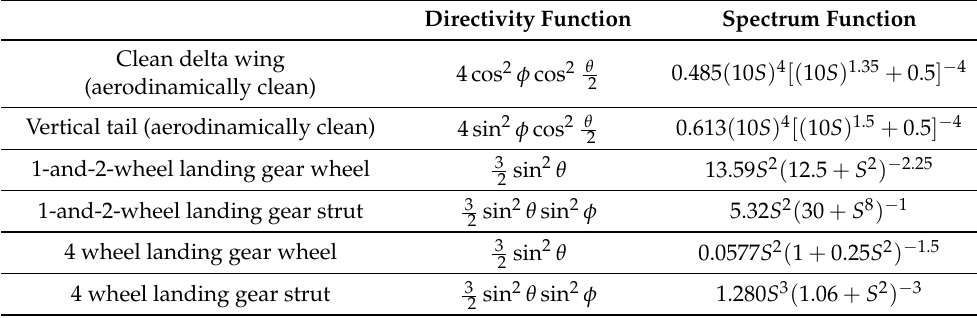
Table 3. Directivity function D and Spectrum function F ( S ) for each airframe noise source